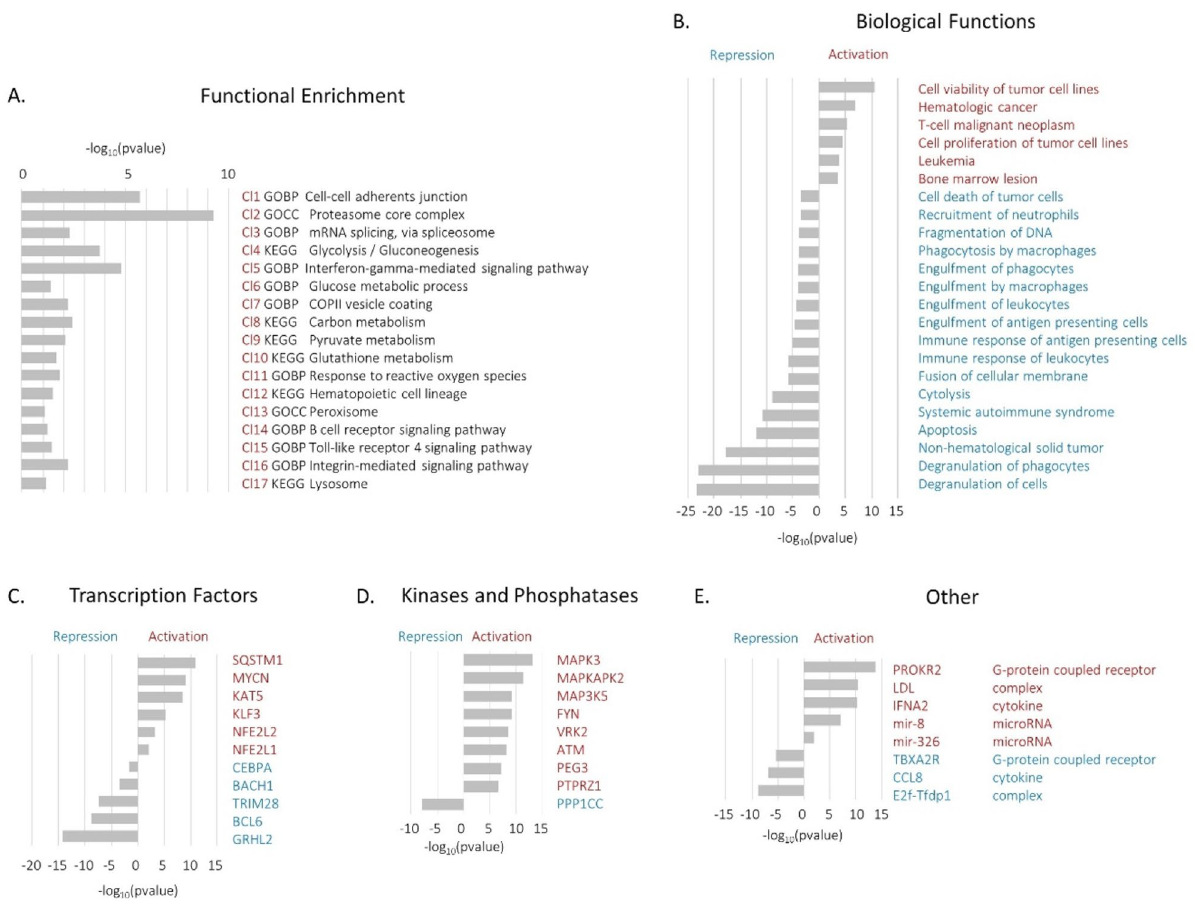
Figure 4. Biological significance of proteins linked to IGHV mutational status. ( A ) Functional annotation analysis performed with the web-based tool DAVID. Representative functional terms for each DAVID cluster have been reported alongside their corrected p value. ( B ) Functional prediction analysis performed using the IPA software. Functional terms predicted to be activated or repressed in UM-CLL compared to M-CLL samples are listed alongside the corrected p value. IPA driver analysis where ( C ) transcription factors, ( D ) kinases and phosphatases and ( E ) other relevant regulatory molecules that are predicted to be activated or repressed in UM-CLL versus M-CLL samples are listed alongside their P